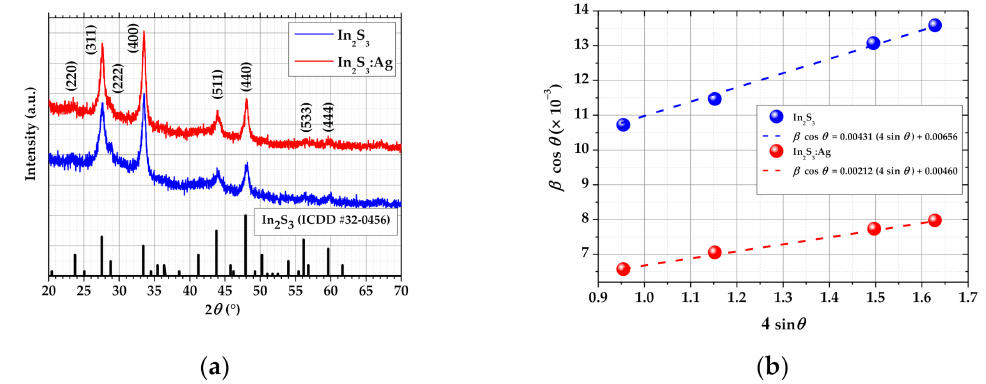
Figure 1. Results from XRD: ( a ) patterns of In 2 S 3 and In 2 S 3 :Ag samples; ( b ) Williamson–Hall plots, based on the parameters of the four most intense XRD peaks of both